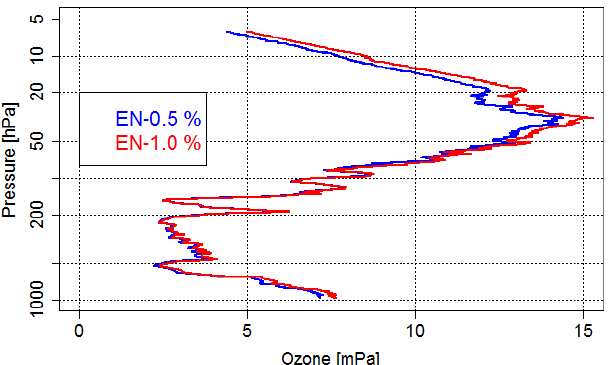
Figure 4. Example of the results of a dual-ozonesonde flight profile from Payerne. The only difference between the ozonesondes is the KI solution